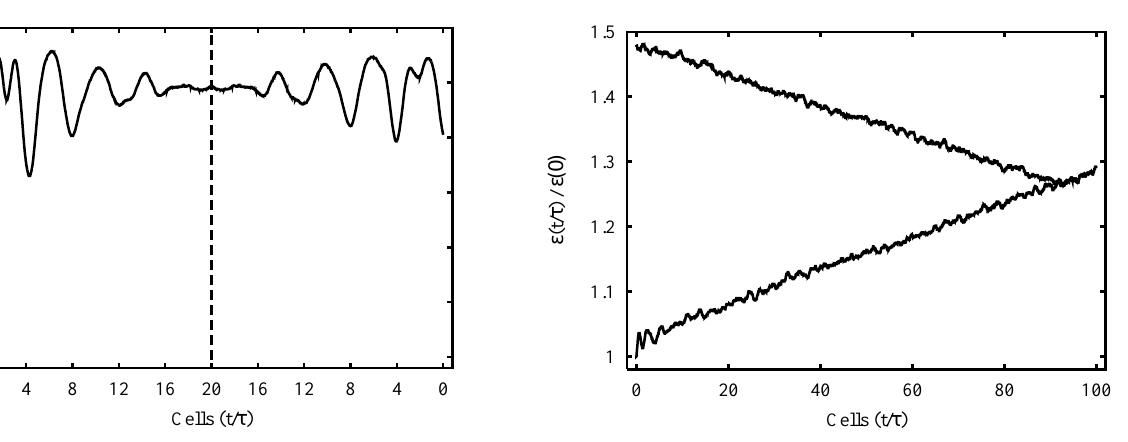
FIG. 3. Emittance growth factors versus the number of cells obtained for a nonstationary initial phase space density at s 0 (cid:1) 60 ± , s (cid:1) 15 ± per cell, 2500 simulation particles. The dashed line marks the point of the time reversal after 20 cells.